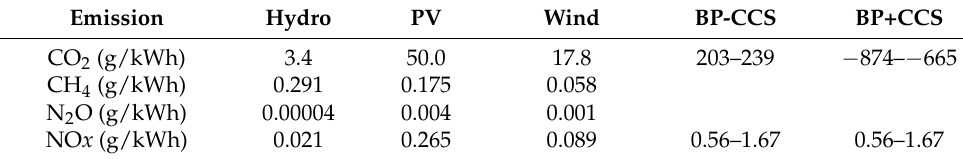
Table 1. GHG and NO x emissions of renewable power from different